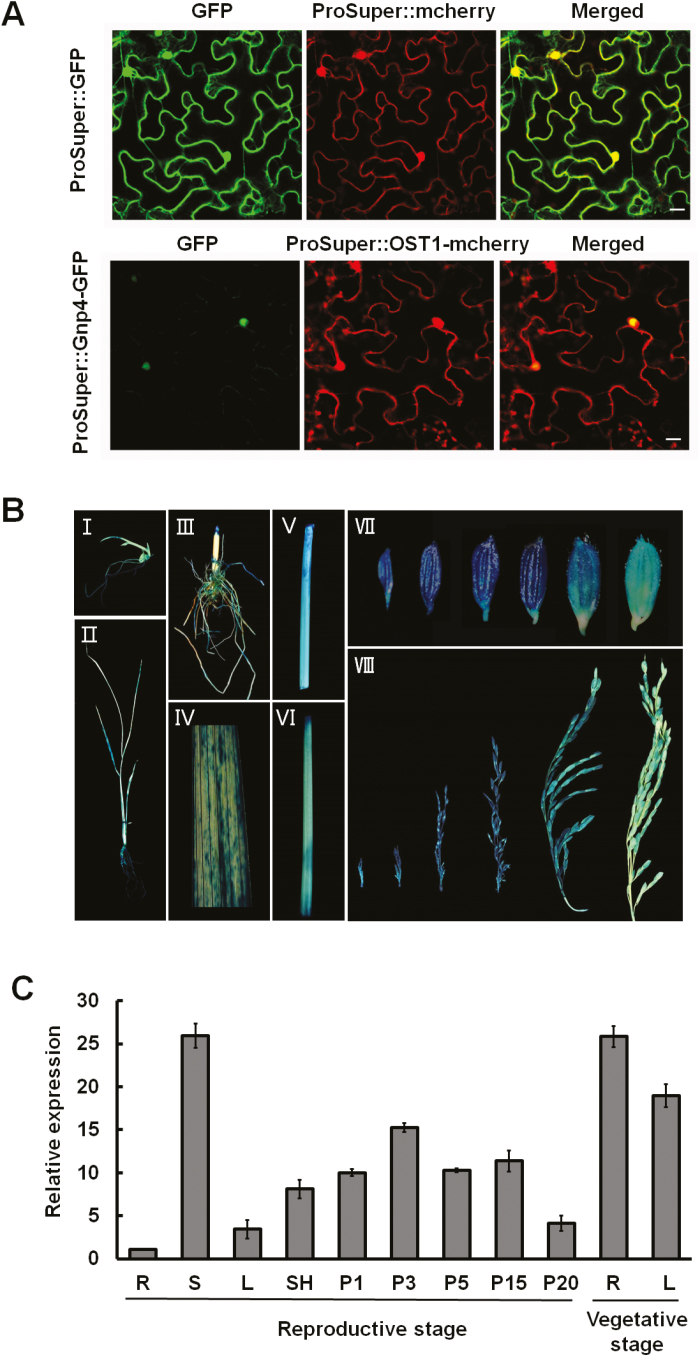
Subcellular localization and expression pattern analyses of Gnp4/LAX2. (A) Subcellular location of ProSuper::GFP and ProSuper::Gnp4-GFP in tobacco leaf cells. ProSuper::OST1-mcherry is a mCherry marker localized in the nucleus and cytosol (Ding et al., 2015). Scale bars are 20 μm. (B) GUS staining of various tissues of transgenic plants containing the ProGnp4::GUS construct. I, bud; II, seedling; III, root; IV, leaf; V, stem; VI, sheath; VII, glumes; and VIII, panicles at different stages. (C) qRT-PCR analysis of relative expression levels of Gnp4 in different tissues from wild-type Nipponbare. R, root; S, stem; L, leaf; SH, leaf sheath; and P, panicles at sequential lengths, where the number indicates the panicle length (cm). Data are means (±s.e.m.) (n=3 plants each with three technical repeats).